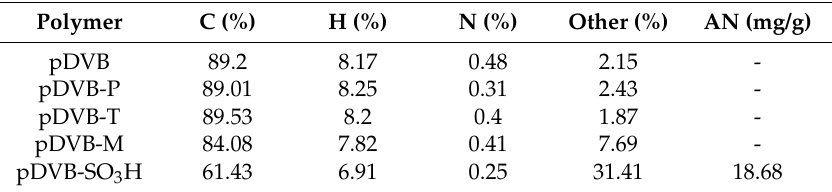
Table 2. The results of elemental analysis and acid number